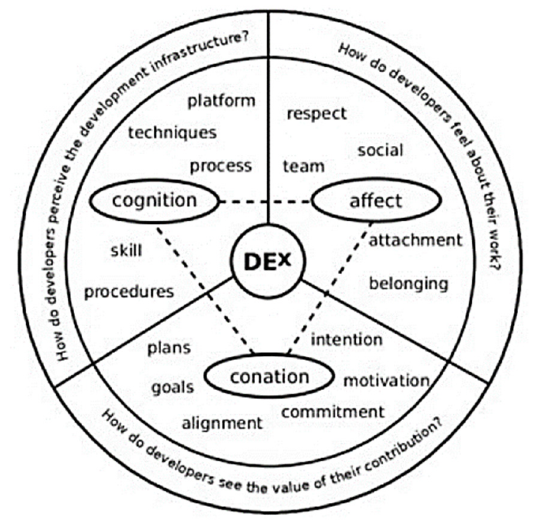
Figure 2. Developer Experience: conceptual framework (adapted from Fagerholm and Münch, 2012).